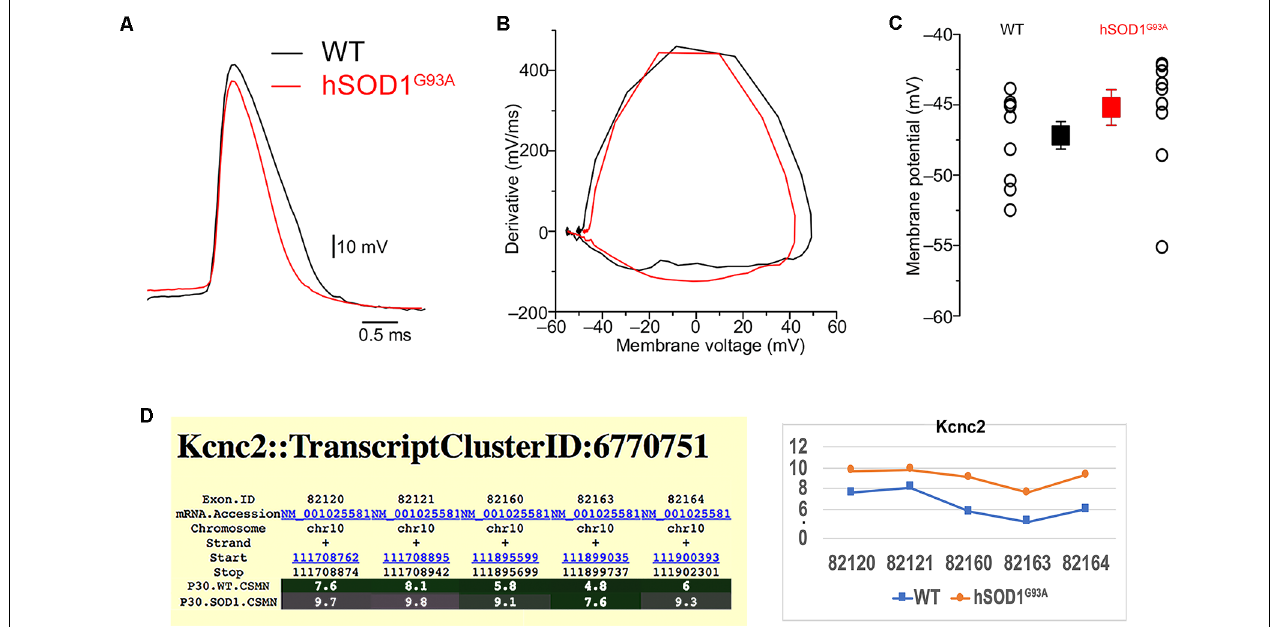
FIGURE 6 | The form of action potential and the threshold in hSOD1 G93A CSMN. (A) Representative traces of action potentials in WT (black) and hSOD1 G93A (red) CSMN. The action potential threshold was measured from the first action potential fired in response to depolarizing current steps at the point where the first derivative was 10 mV/ms. (B) First derivatives of the traces in (A) . (C) Summary plot showing the action potential threshold for WT and hSOD1 G93A CSMN (WT: − 47.2 ± 0.9 mV, n = 9; hSOD1 G93A : − 45.2 ± 1.3 mV, n = 13). (D) Gene expression analysis of Kcnc2. Expression values for each exon are plotted to the right.